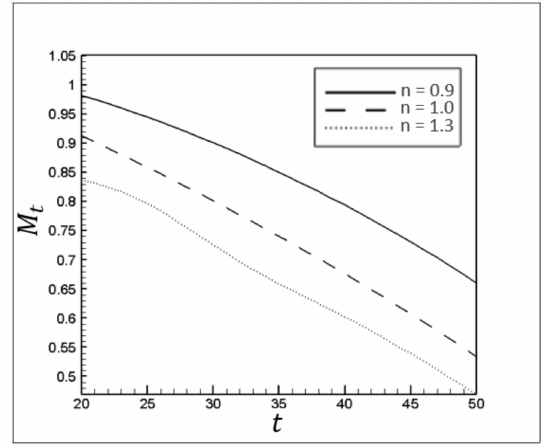
Figure 11. Displacement efficiency versus time for different n.